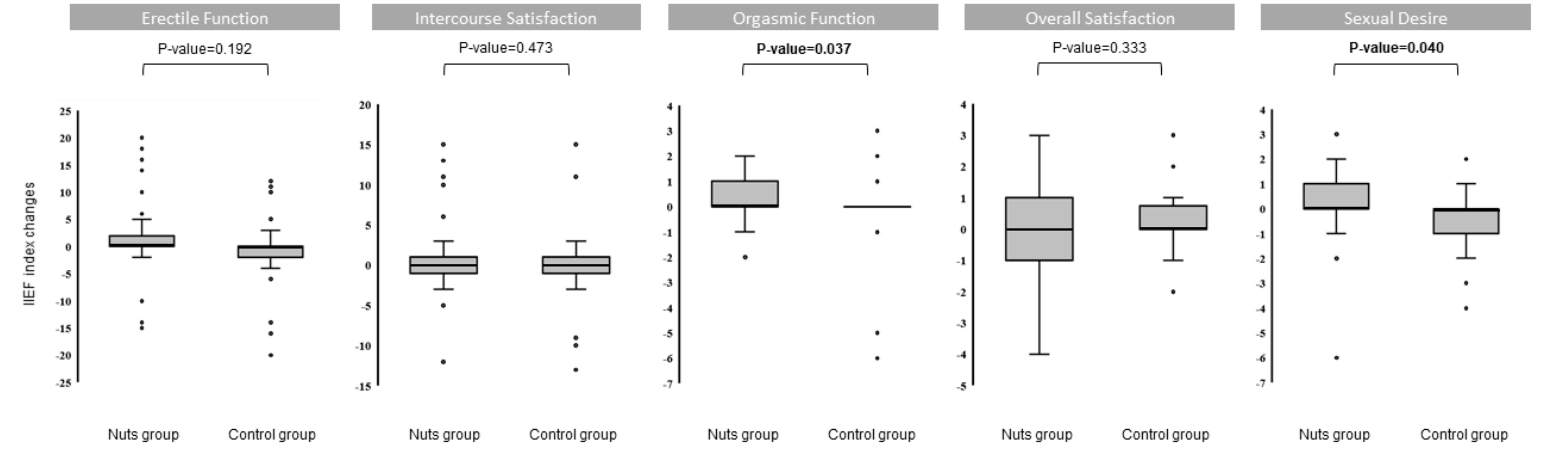
Figure 2. Box plot of the differences between the control group and the nut-supplemented group in the erectile function parameters (IIEF-15). ANCOVA models were used to assess differences between intervention groups. Changes were adjusted for baseline values. A horizontal line in the boxplot illustrates the median value. The upper and lower bars indicate the third and first percentiles, respectively. Outliers are plotted as individual circles. Abbreviations: IIEF: International Index of Erectile Function.